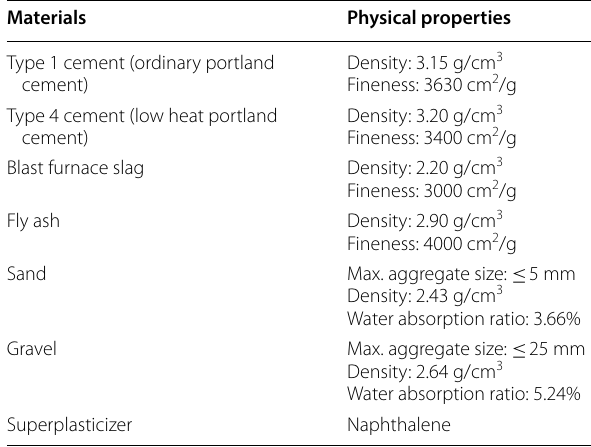
Table 2 Physical properties of